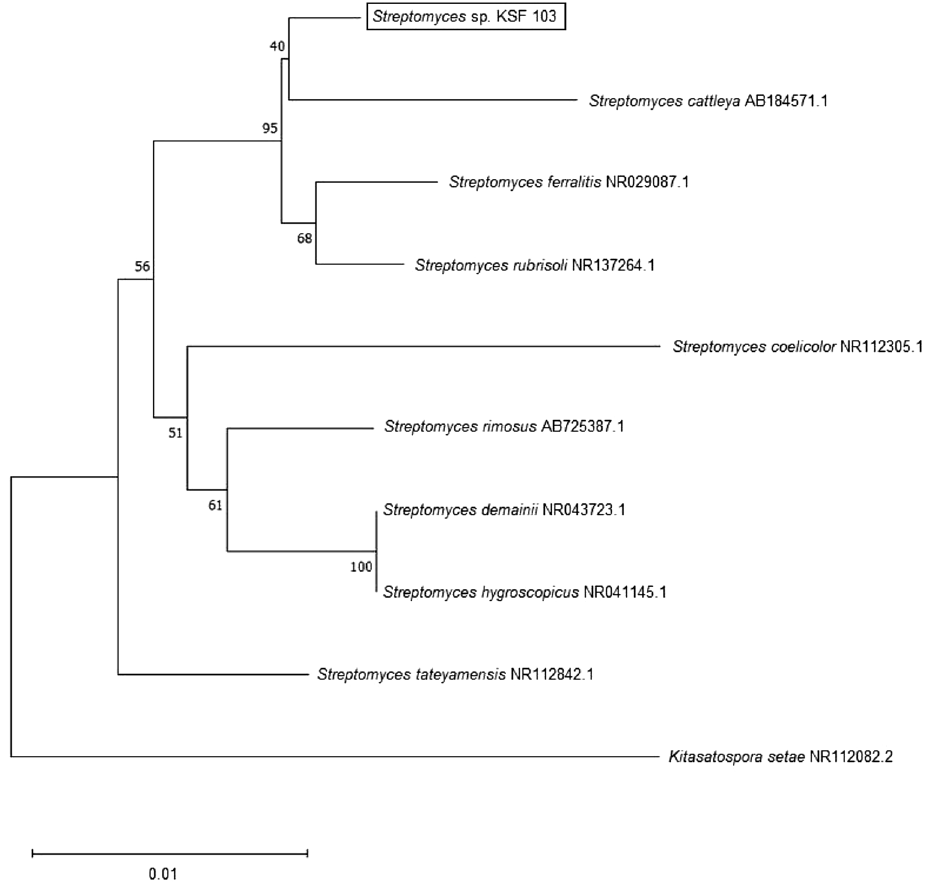
Figure 1. Phylogenetic tree based on the 16S rRNA gene sequences using the neighbour-joining method for the Streptomyces sp. KSF103 and its closely related type strains. The number of branch nodes is bootstrap values (1000 resampling). The scale bar represents 0.01 substitutions per